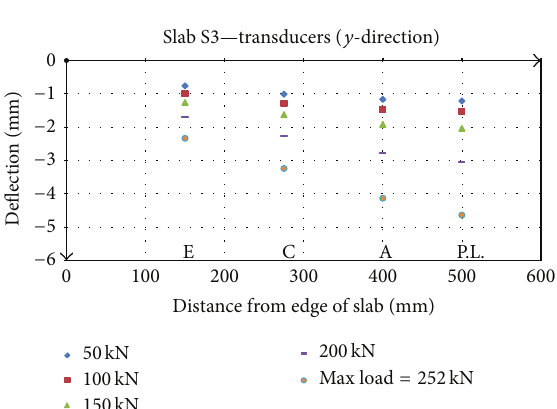
Figure 44: Load V’s strain (average readings).